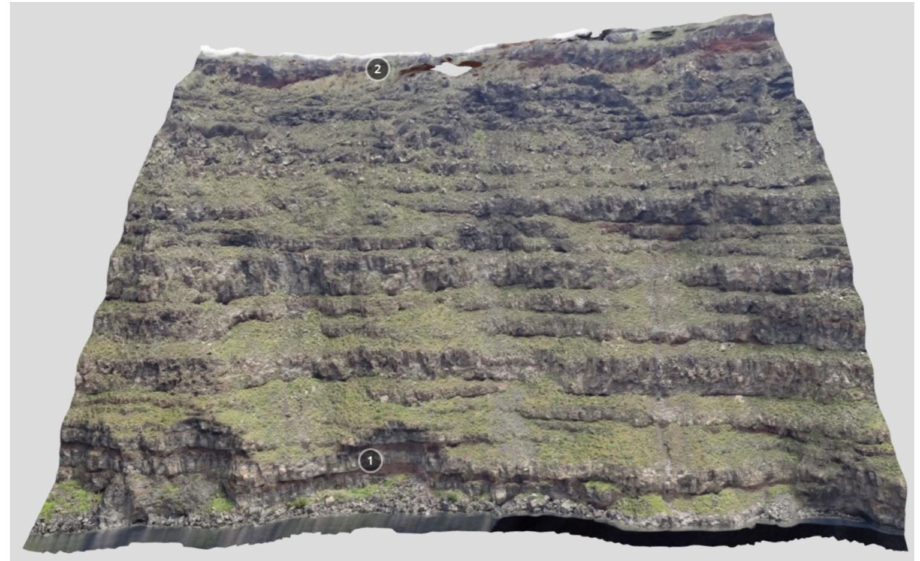
Figure 15. Panorama of the Skaros shield 3D model. The outcrop has an elevation of 240